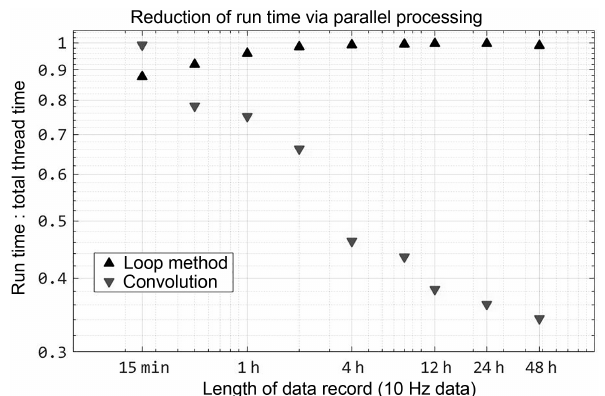
Figure 2. Fast calculation of larger data sets is due to implicit paral- lel processing via the FFT, which is readily performed by multiple simultaneous threads. The efficiency of parallel processing is shown by a lower ratio of run time to total thread